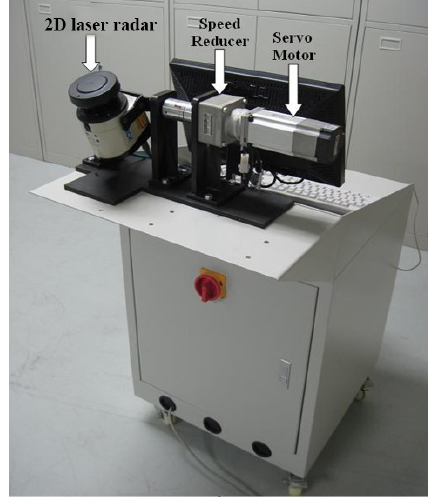
Figure 1. Laser radar measurement system (LRMS) configuration.